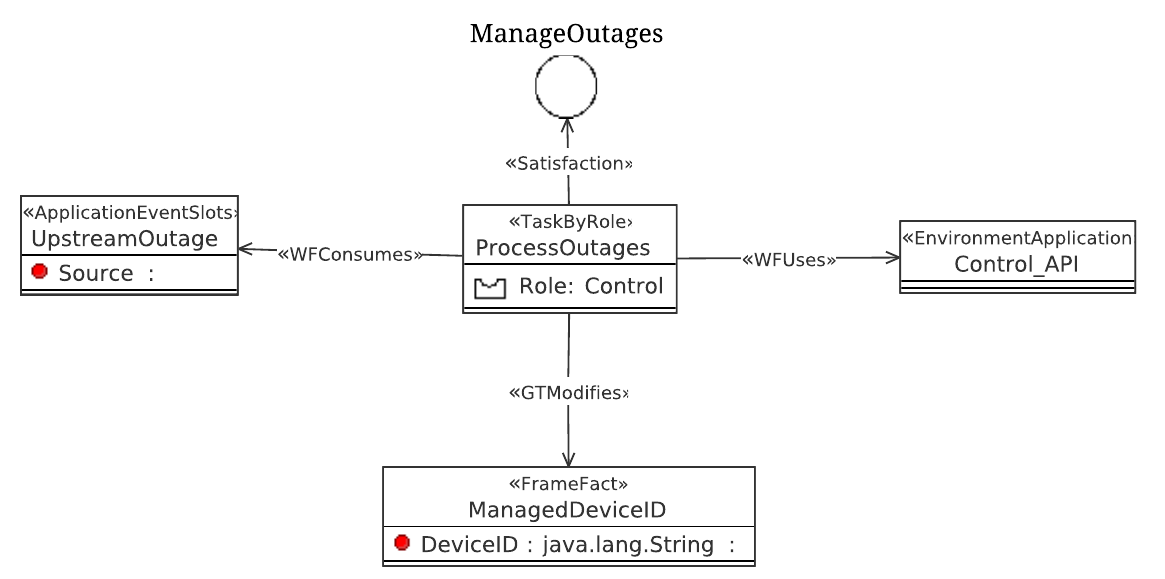
Figure 4. Blackout management